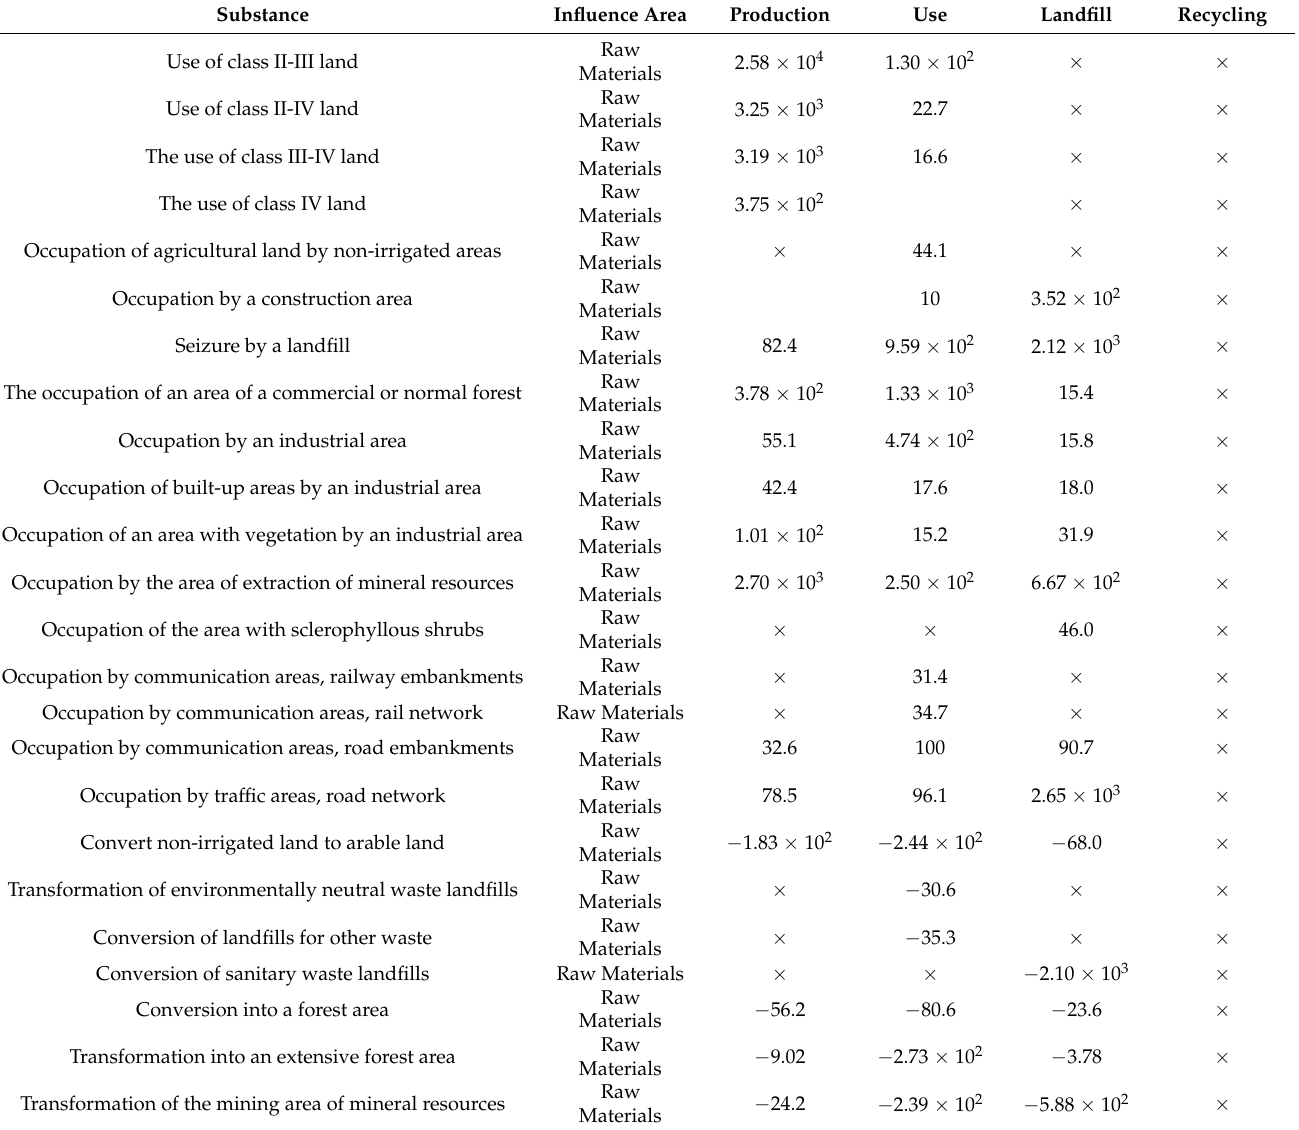
Table 7 presents the results characterizing the environmental consequences for ozone layer depletion occurring in the various stages of the life cycle of the Vestas V90 wind farm. The analyses conducted revealed a significantly high detrimental effect in the pro- duction stage, especially for bromotrifluoromethane (0.001 DALY) and 1,2-dichloro-1,1,2,2- tetrafluoroethane (0.0001 DALY) in this category of the environmental impacts of the investigated technical object. The highest level of harmful impact occurs during the pro- duction stage due to the production of the plastics, materials and wind turbine components (0.0012 DALY). Recycling will make it possible to minimize negative impacts throughout the life cycle in the analyzed category by a total of − 0.0001 DALY. Table 8. The results of the research characterizing the environmental consequences for the processes related to land use occurring in the various stages of the life cycle of the Vestas V90 wind farm, PDF m 2 /y [own